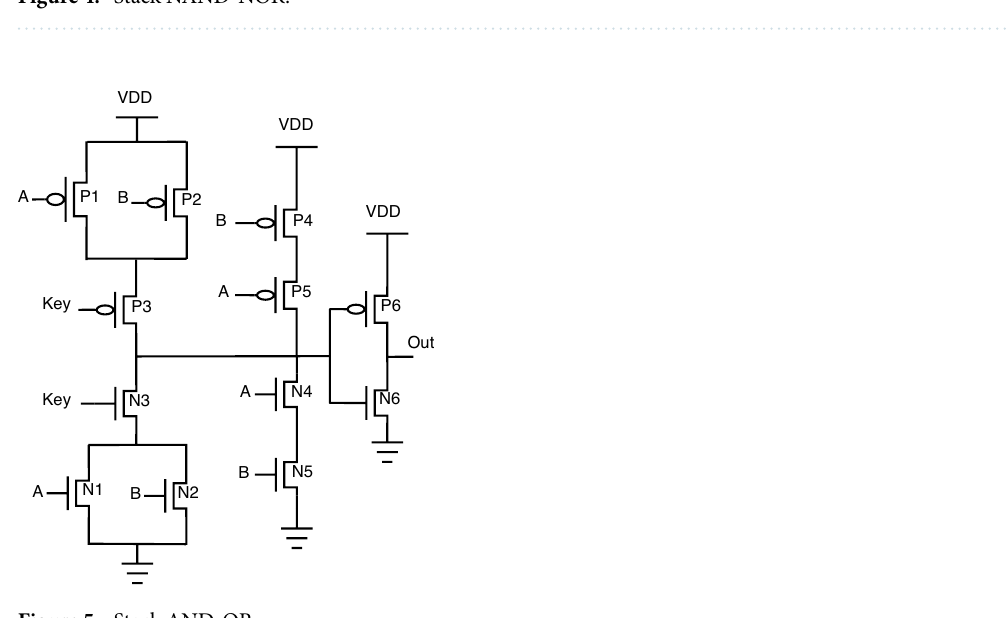
Figure 4. Stack NAND-NOR.